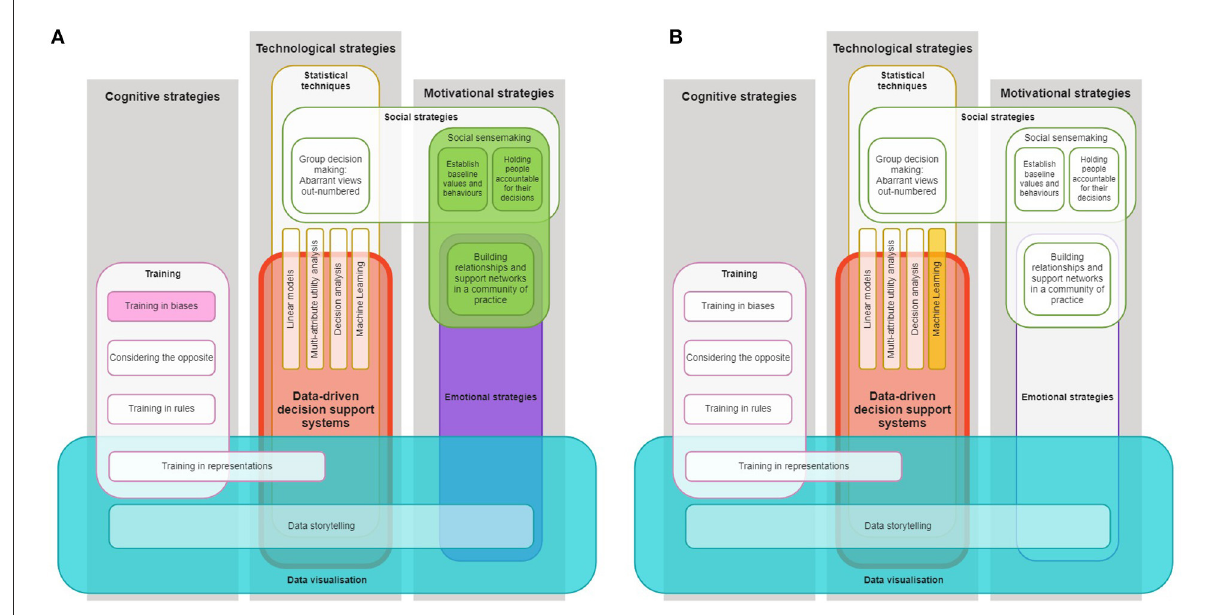
FIGURE3 Debiasing with data-driven technologies framework as applied to (A) the EQUIP intervention (Reinholz et al., 2020a,b) and (B) an intervention to identify at-risk students (Pei and Xing, 2021). Only strategies represented by color-filled blocks are applied in these